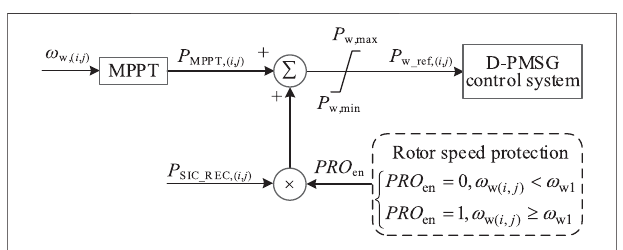
FIGURE 5 | Structure of CSIC considering the rotor speed recovery process.